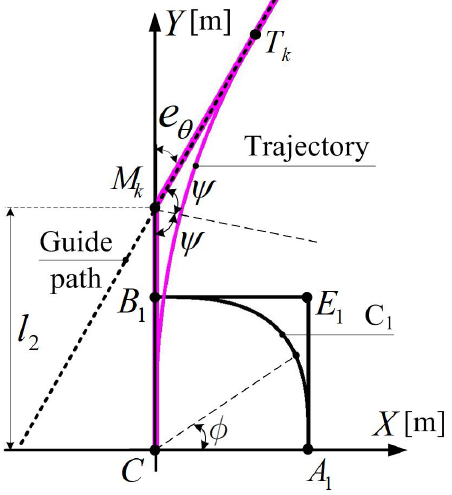
Figure 6. Path tracking based on trajectory blending.